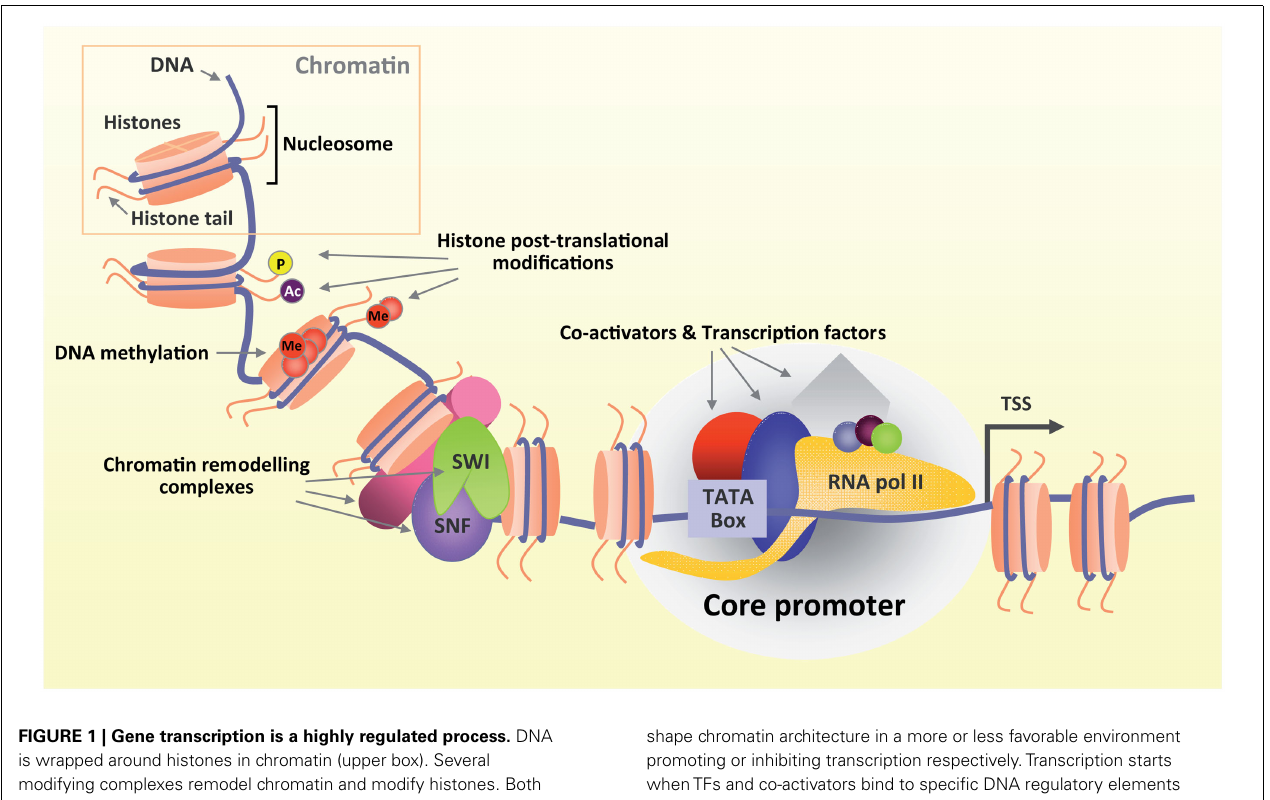
FIGURE 1 | Gene transcription is a highly regulated process. DNA is wrapped around histones in chromatin (upper box). Several modifying complexes remodel chromatin and modify histones. Both DNA and histone tails undergo post translational modifications (Ac, acetylation; Me, methylation; P, phosphorylation) that ultimately